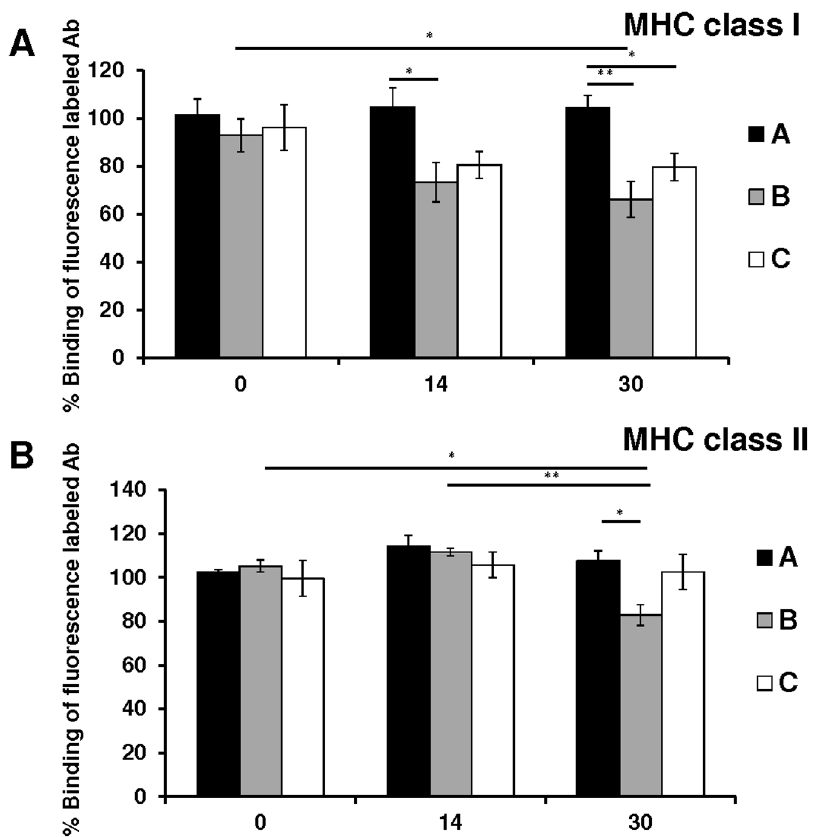
Figure 1. Dynamic of anti splenic cells MHC class I and II antibodies concentrations. The percentage binding of the fluorescence-labelled MHC class I (A) and MHC class II (B) antibody to BN splenic cells in the presence of sera from group A, B, or C obtained on day 0, 14, or 30 after transplantation. Sera from the allogeneic non-immunosuppressed group B, taken on day 30, significantly inhibited fluorescence-labelled MHC class I and MHC class II antibody binding to splenic cells, compared to day 0 sera. Error bars represent SEM, * p , 0.05, ** p , 0.01.